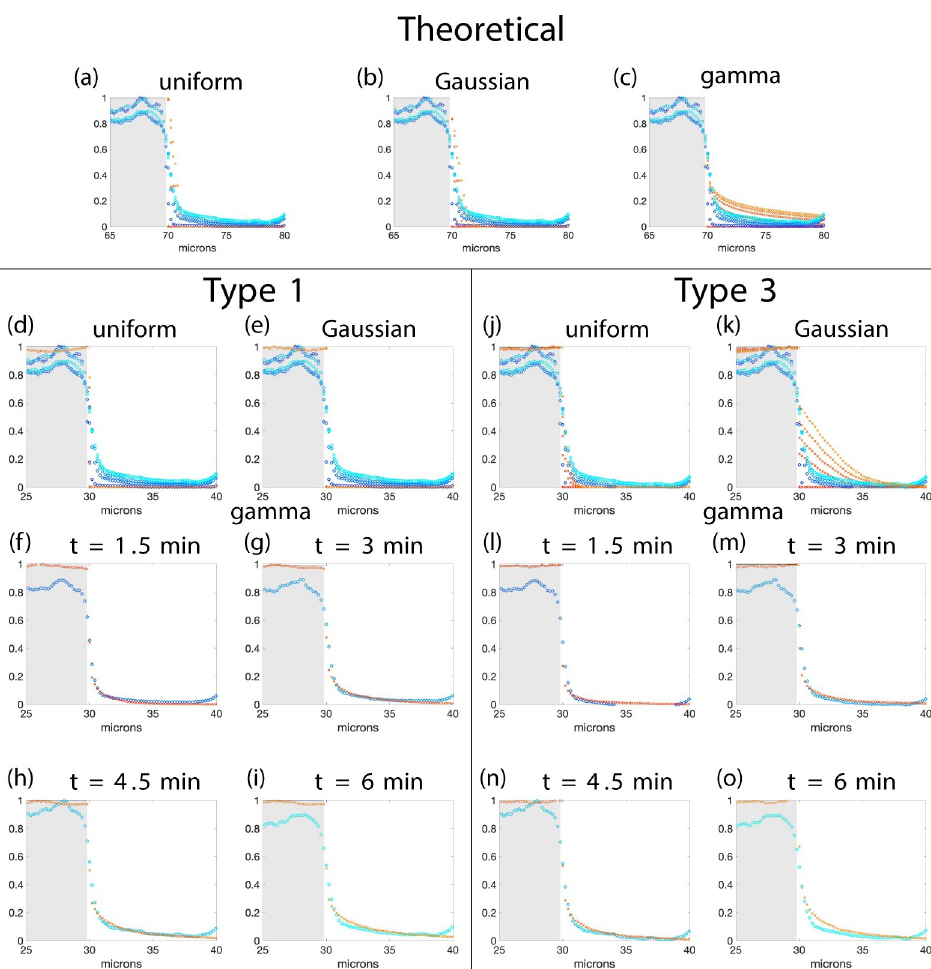
Fig 8. Fitting simulations to the experimental data. This figure compares the simulated results (red shades) with experimental data (blue shades) for one data set. The figure has been separated into three regions showing results from the theoretical model, type 1 simulations, and type 3 simulations. Panels (a)-(e), (j), and (k) show all the time data together, whereas the rest show the time data in individual panels. When optimizing only the data in the unshaded area is used. The minimum value of the objective function is 0.0511, 0.0525, and 0.0139 for type 1 and for type 3 0.0415, 0.0404, and 0.0131 for uniform, Gaussian, and gamma distributed velocity respectively. The y axis is fluorescence intensity (a.u.) in all panels. Length : All—uniform with mean 5.025